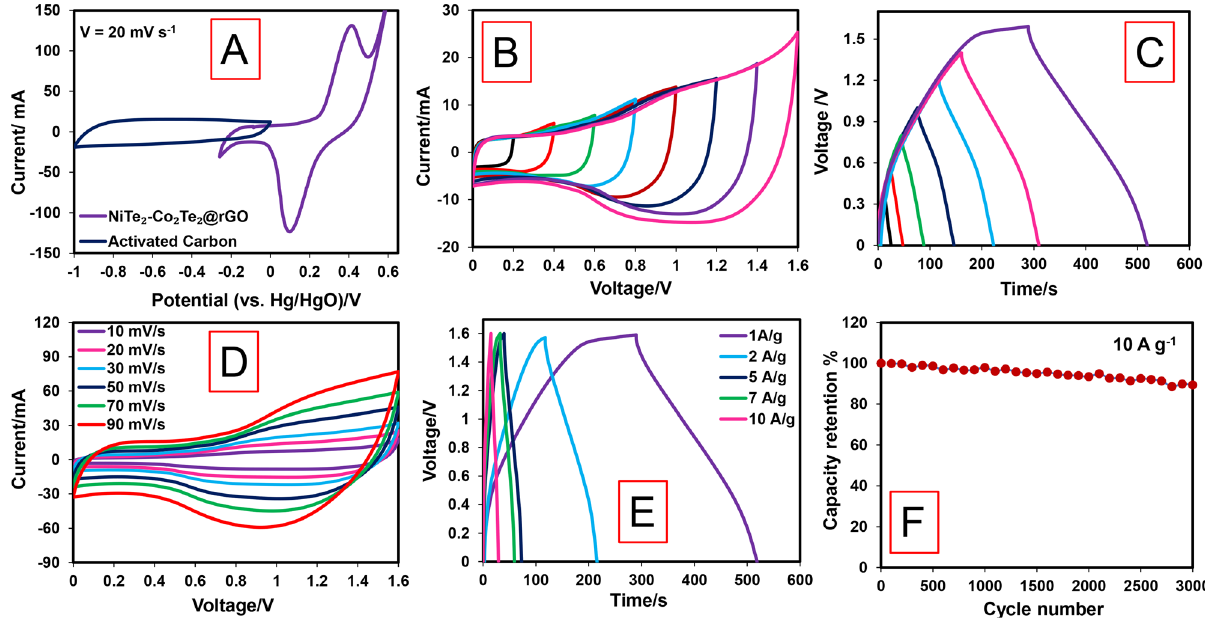
Figure 5. Electrochemical performance measurements in HSC device: ( A ) CV curves of the activated carbon and NiTe 2 -Co 2 Te 2 @rGO electrodes at a scan rate of 20 mV s −1 in a three-electrode system in 1.0 M KOH, ( B ) CV curves at different potential windows (0.2–1.6 V) at a scan rate of 20 mV s −1 , ( C ) GCD curves at different potential windows (0.2–1.6 V) at a current density of 1.0 A g −1 , ( D ) CV curves at various scan rate (10– 90 mV s −1 ), ( E ) GCD curves at different current densities (1–10 A g −1 ), and ( F ) cycling performance at 10 A g −1 of the NiTe 2 -Co 2 Te 2 @rGO HSC device.